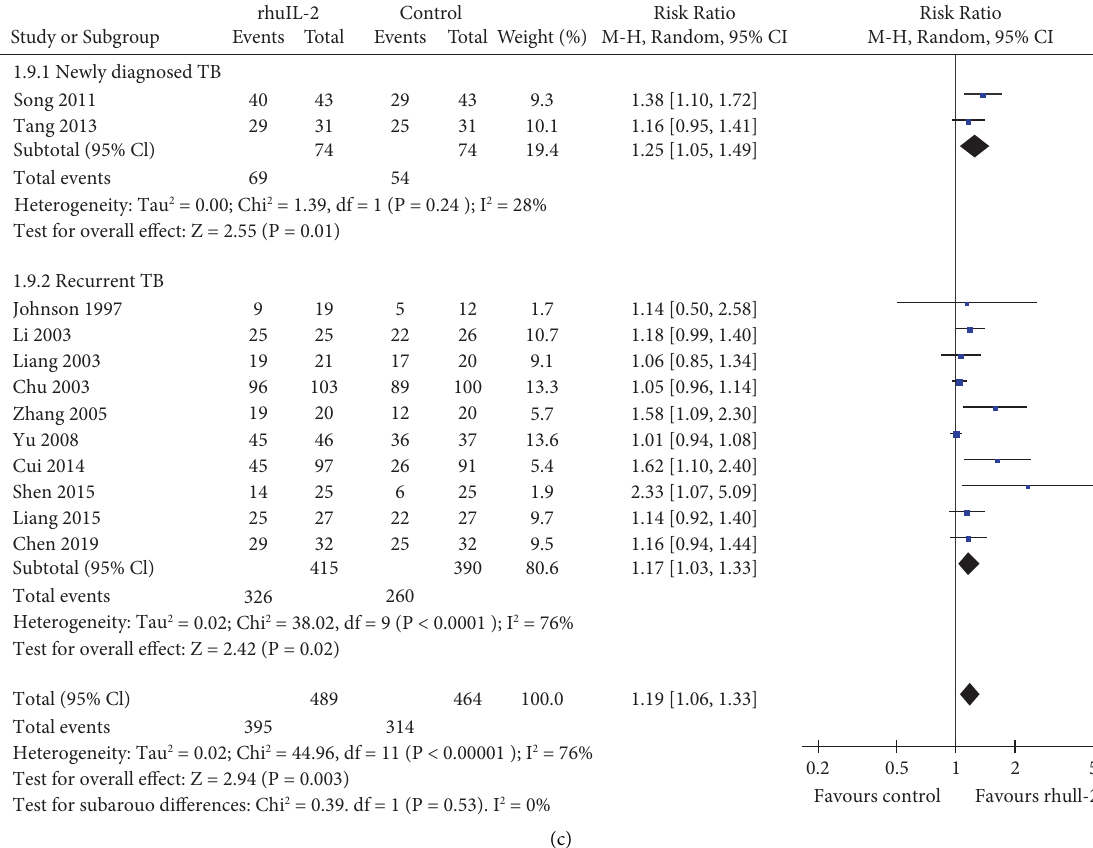
Figure 4: Forest plots for the meta-analysis of the efect of rhuIL-2 on the proportion of patients with radiographic focus absorption; (a), forest plots for the overall meta-analysis; (b), forest plots for the subgroup analysis according to the drug sensitivity of TB; and (c), forest plots for the subgroup analysis in newly diagnosed and recurrent